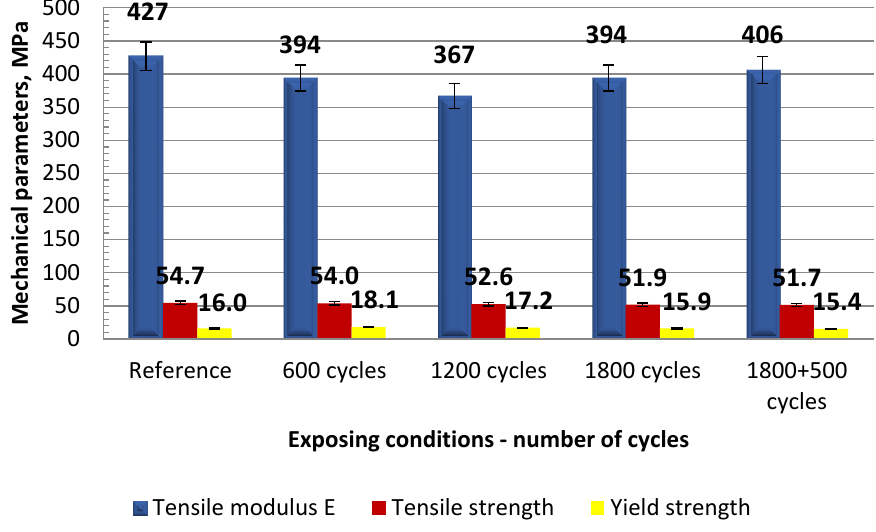
Figure 17. Strength parameters of samples exposed in the thermal shock chamber.